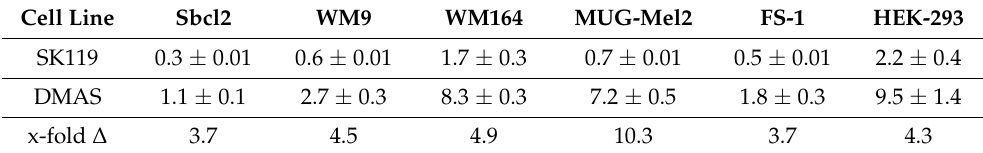
Table 2. IC 50 values ( µ M) of SK119 after 72 h treatment compared to the most active, formerly isolated derivative DMAS; (mean ± SD, n = 6). x-fold ∆ : x-fold difference of the IC 50 values = IC 50 DMAS /IC 50 SK119 . IC 50 values were determined using the four-parameter logistic curve. Cell Line Sbcl2 WM9 WM164 MUG-Mel2 FS-1 HEK-293 SK119 0.3 ± 0.01 0.6 ± 0.01 1.7 ± 0.3 0.7 ± 0.01 0.5 ± 0.01 2.2 ± 0.4 DMAS 1.1 ± 0.1 2.7 ± 0.3 8.3 ± 0.3 7.2 ± 0.5 1.8 ± 0.3 9.5 ± 1.4 x-fold ∆ 3.7 4.5 4.9 10.3 3.7